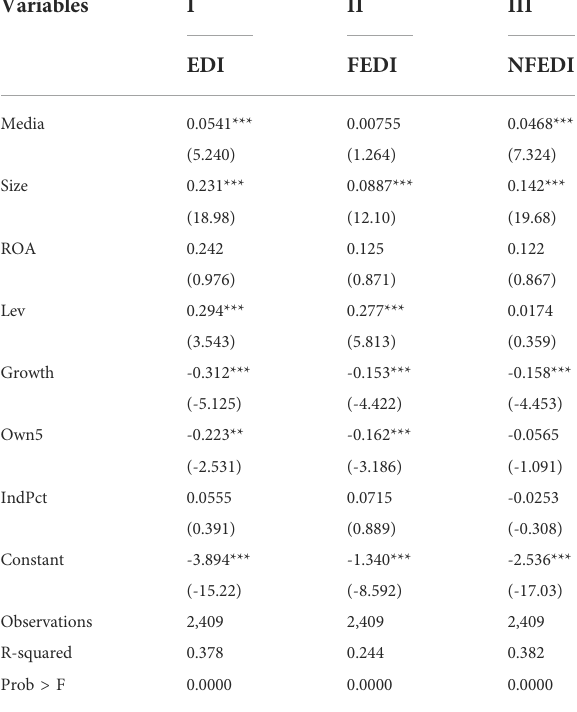
TABLE 5 Regression results of Media and